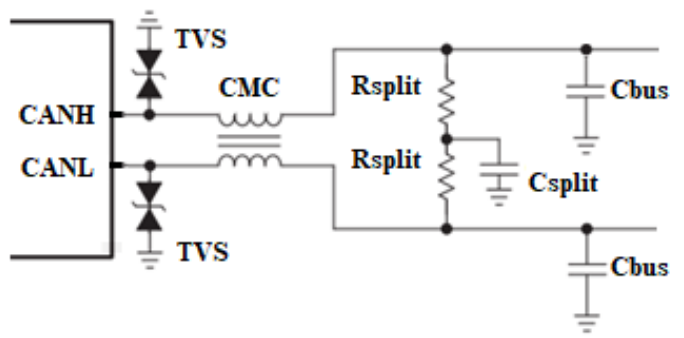
Figure 8. Typical solution for CAN bus protection against conducted disturbances.